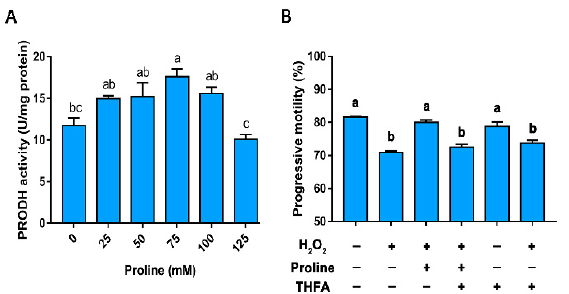
Figure 7. The role of proline dehydrogenase in the antioxidant properties of proline. ( A ) Effect of proline on the activity of PRODH on day 5 of storage. ( B ) Effect of inhibition of proline dehydrogenase on the progressive motility of sperm during H 2 O exposure. Samples were treated with or without H 2 O 2 in the presence of proline or THFA and incubated at 37 °C for 2 h. Columns with nonidentical superscripts are significantly ( p < 0.05) different from each other in statistics.